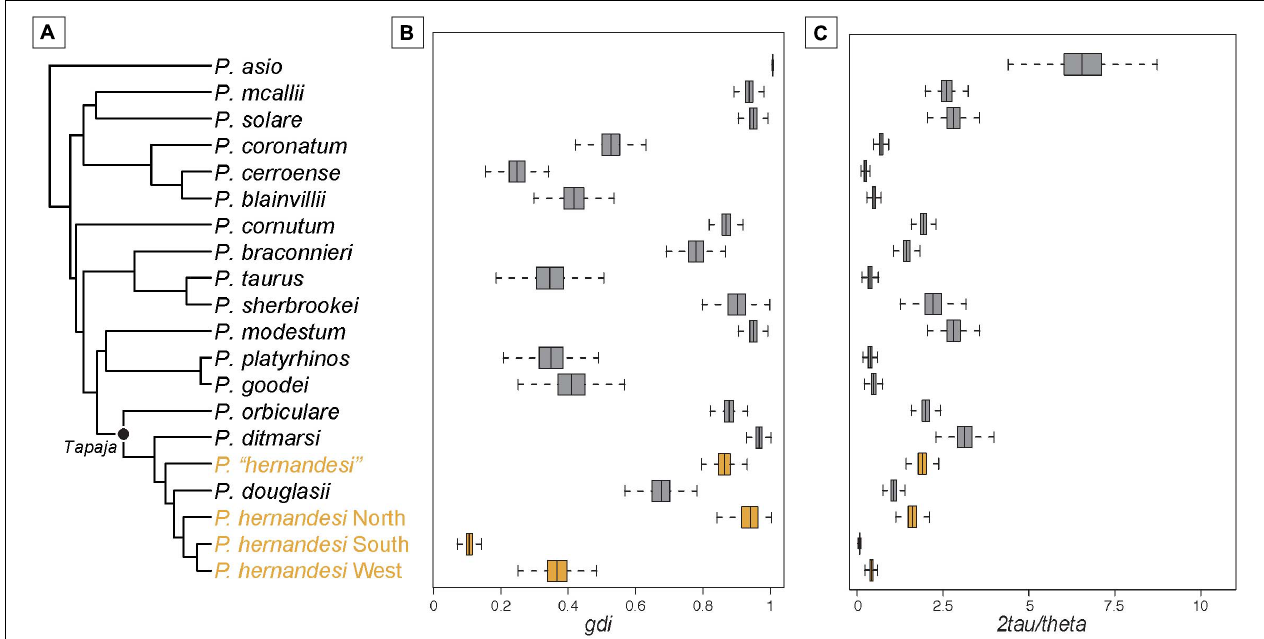
FIGURE 4 | Comparison of Phrynosoma populations and species using measures of divergence. (A) Guide-tree used for the multispecies coalescent (MSC) estimation of population sizes ( θ ) and divergence times ( τ ) in BPP. The topology was estimated using 584 nuclear loci (Leaché and Linkem, 2015). The topology for the Short-horned Lizards ( Tapaja ) has been updated to include the populations shown in Figures 1 , 2 . Box and whisker plots for gdi (B) and coalescent units (C) calculated using the posterior probability distributions for θ and τ estimated with BPP.